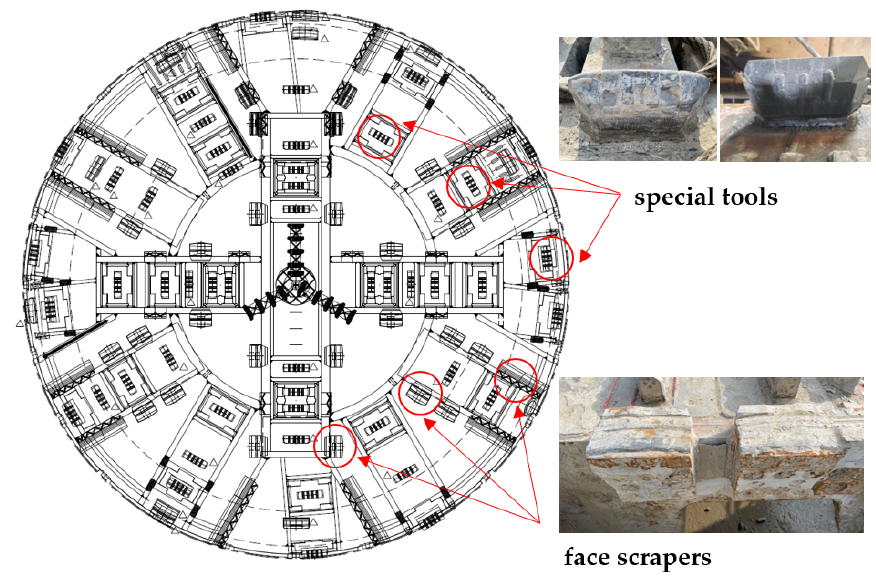
Figure 3. Cutter head and layout of